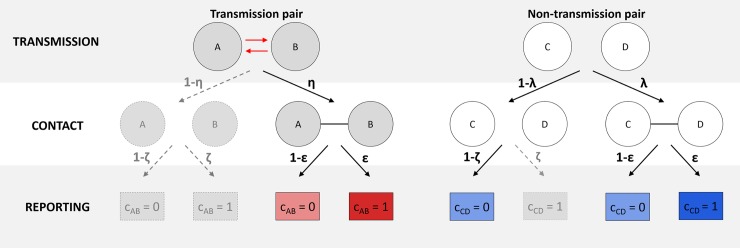
Modelling contact data from transmission trees.Circles represent sampled, infected individuals. ci,j represents the contact status between cases i and j, with 1 indicating a reported contact and 0 the absence of a reported contact. Transmission pairs and non-transmission pairs experience contact with probabilities η and λ, respectively. These contacts are reported with probability ε. False positive reporting of contacts that have not occurred occurs with probability ζ. In the simplified model implemented in outbreaker2, as indicated by colored shading and solid outlines, η is assumed to be 1 and ζ assumed to be 0.